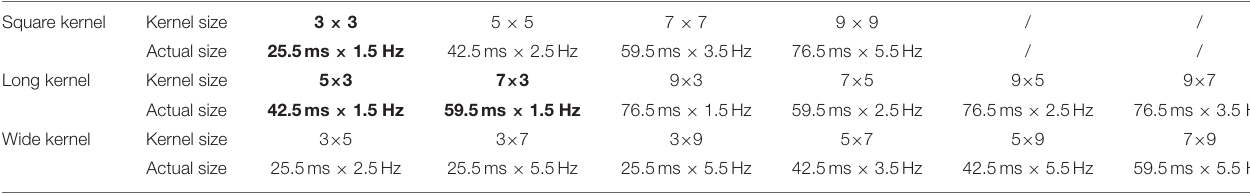
The bold value shows the best three convolution kernel